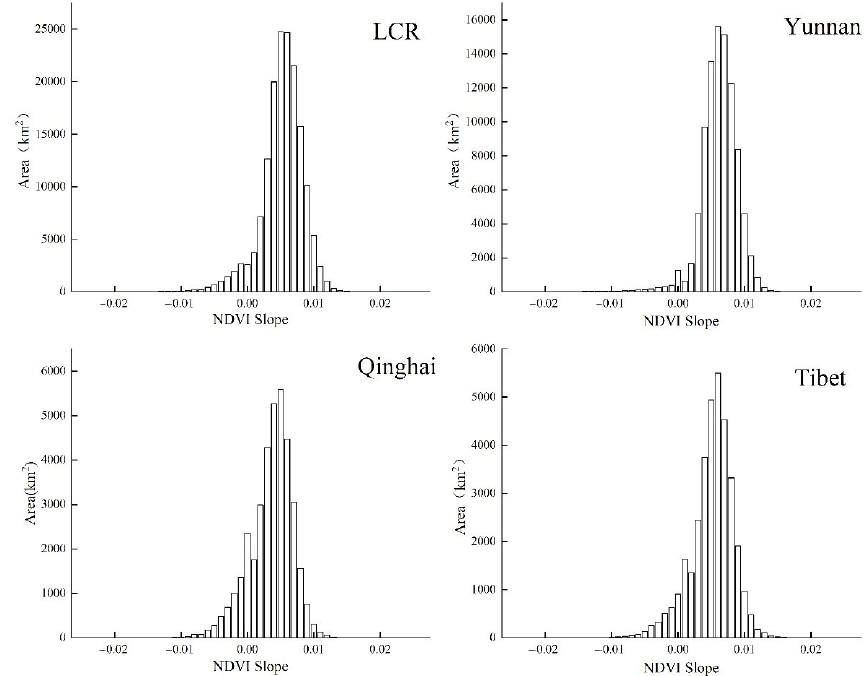
Figure 4. The change rate of NDVI in different regions of the Lancang River Basin.